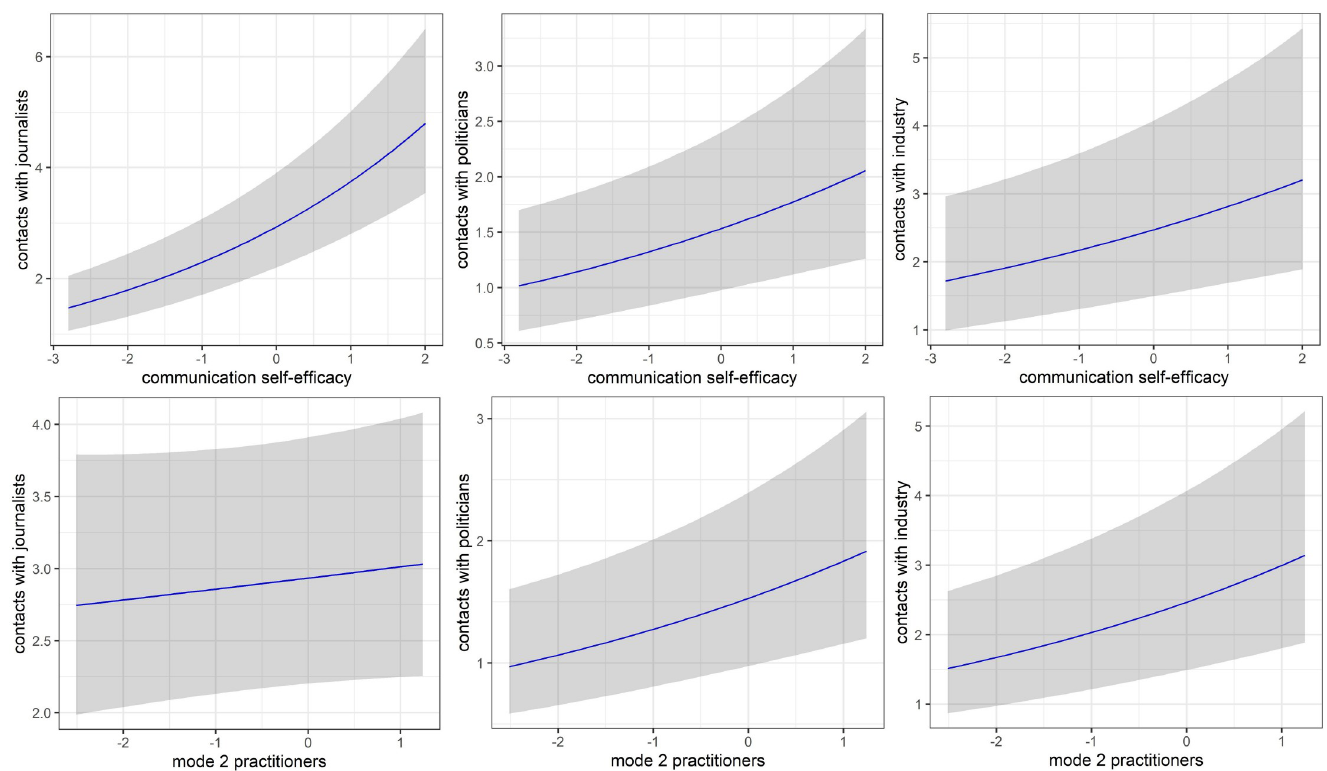
Fig 2. Marginal effects for the predictors internal efficacy (top) mode 2 practitioners (bottom) (M = 0, SD = 1) for all three outcome variables. Gray area shows the credible intervals (95%).